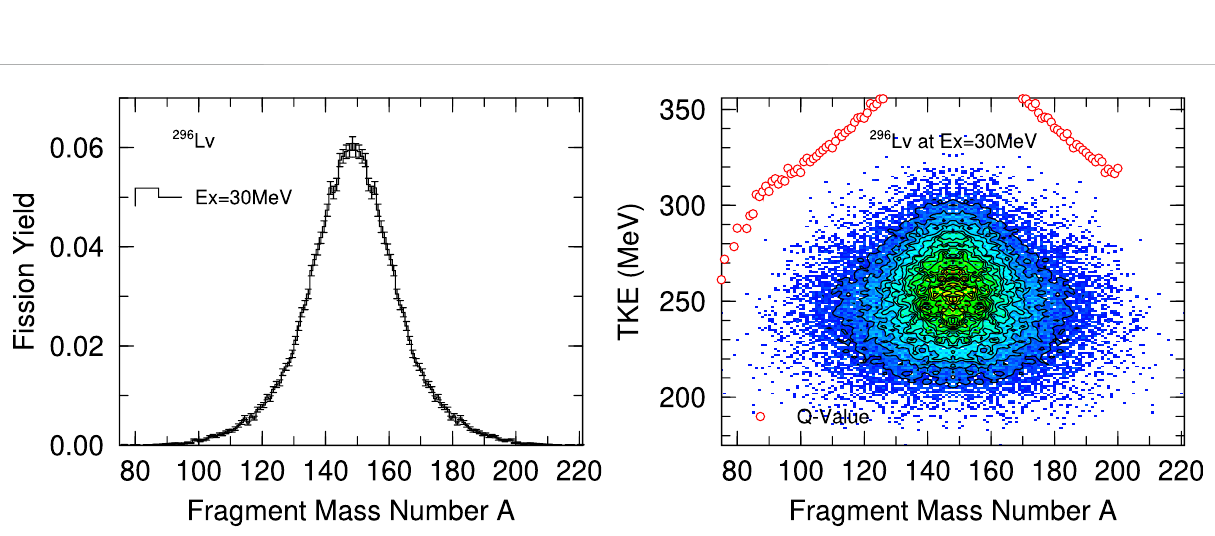
have four peak structures in the FFMDs, as seen in Figure 3. In Figure 9, pairs of fi lled triangles correspond to the main peaks, while those of open triangles are the sub-peak positions. We plot solid lines